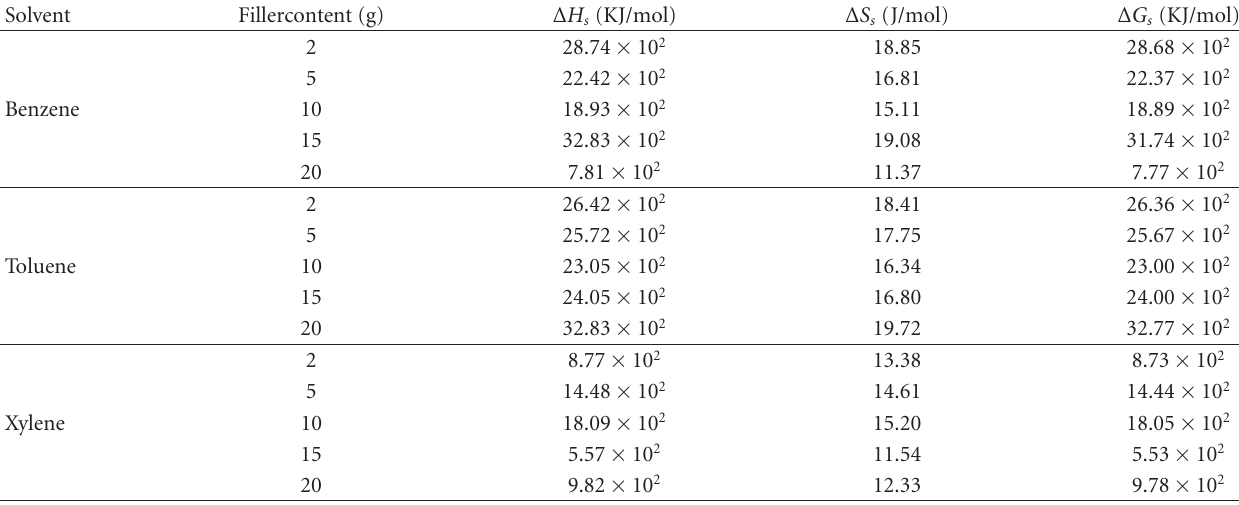
Table 7: Values of enthalpy of absorption ( Δ H s ), entropy of absorption ( Δ S s ), and Gibbs free energy ( Δ G s ) of snail shell powder filled natural rubber (filler particle size, 0.075 μ m).